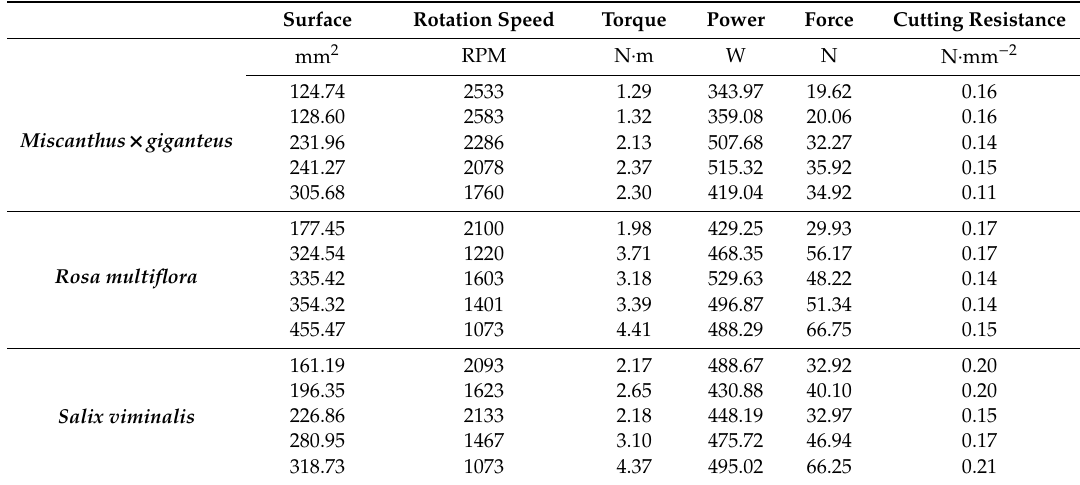
Table 5. The average cutting resistance at the initial rotation speed n 2 = 3200 RPM.